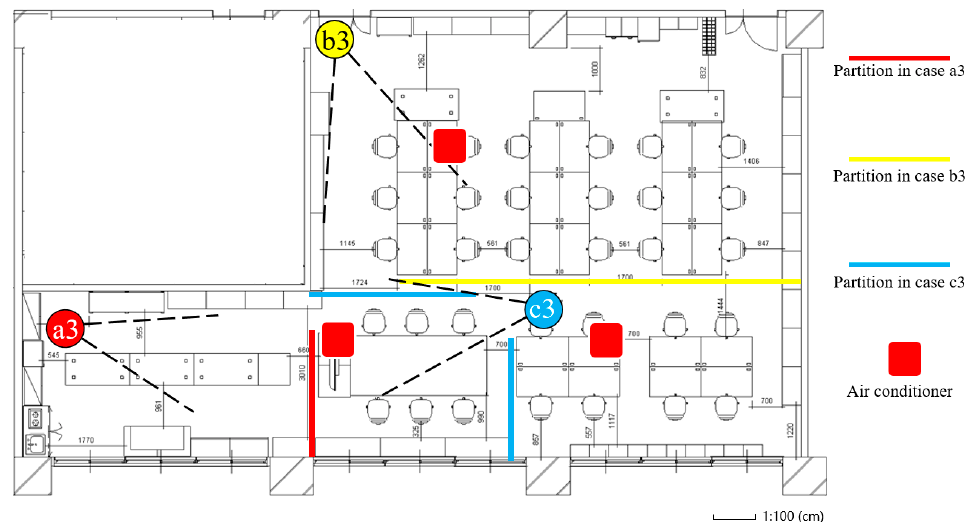
Figure 17. Observation position and field of view.